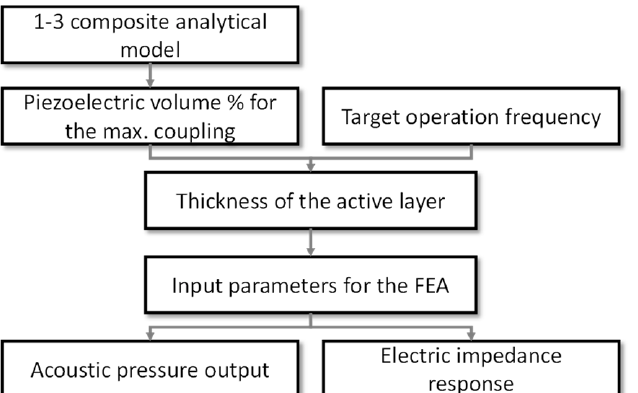
Figure 4. Design procedure of the miniaturized, 1–3 piezoelectric composite, focused ultrasound transducer.